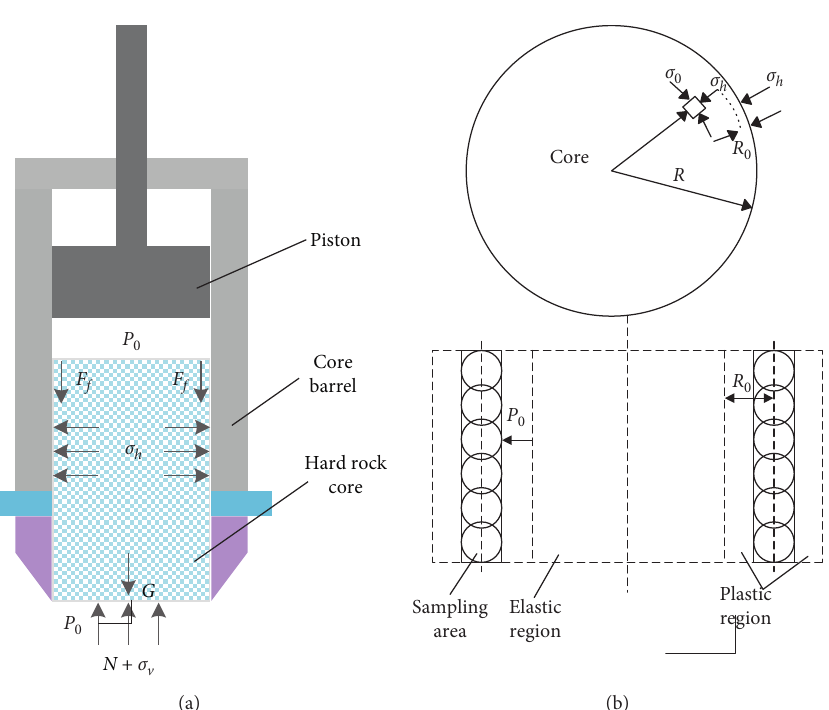
Figure 1: Mechanical analysis of coring system. (a) The schematic diagram of the core axial force under the core bit structure and (b) the radial force of the core.